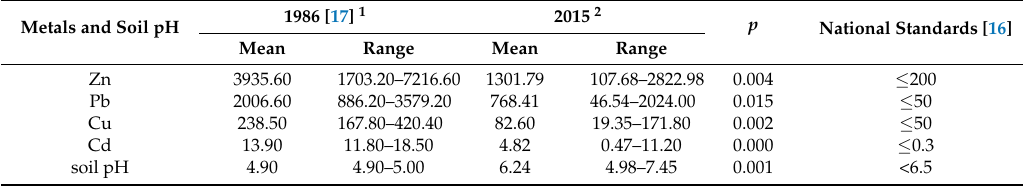
Table 1. Total contents of topsoil (0–20 cm) metals in 1986 and 2015